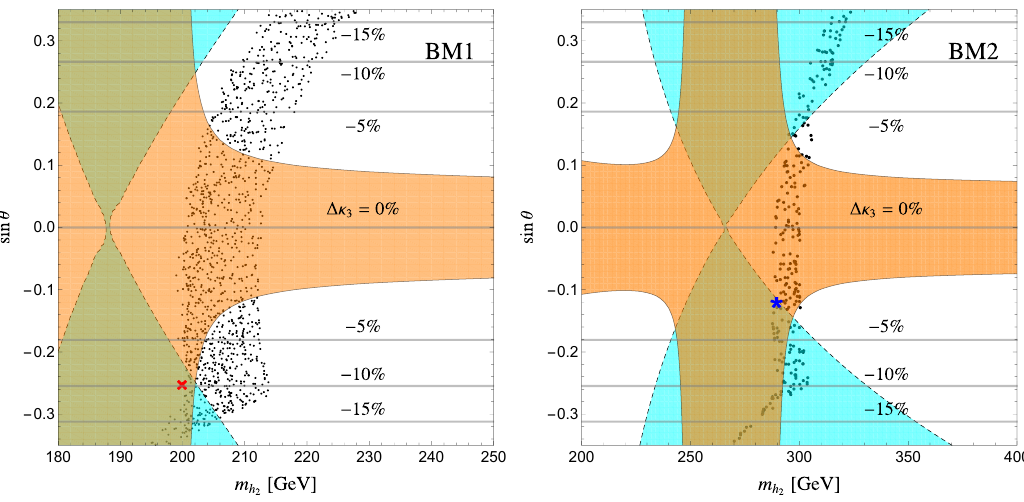
Figure 10. Contour plot on sin θ - m h plane. The orange (cyan) shaded regions are allowed by 2 DM direct detection (relic density). The dashed lines indicate the value of ∆ κ 3 defined in eq. (3.28). The black points give strong FOPT. The red cross at left panel and blue star at right panel are our BM1 and BM2 points,